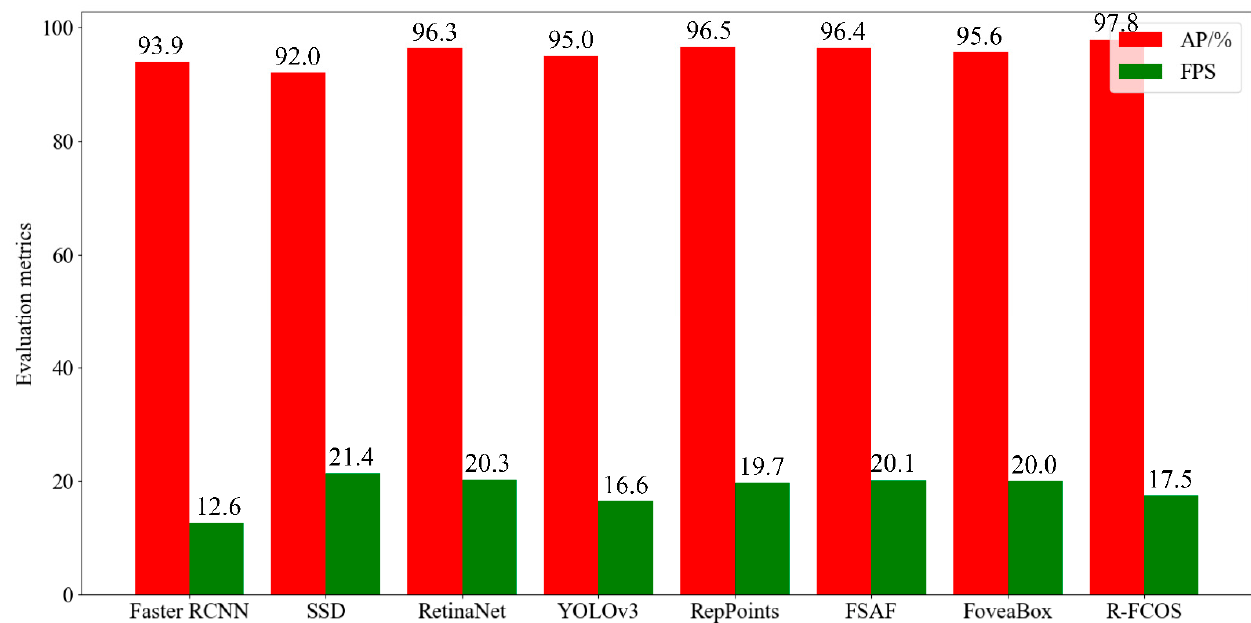
Figure 13. The bar graph of different methods on SSDD.